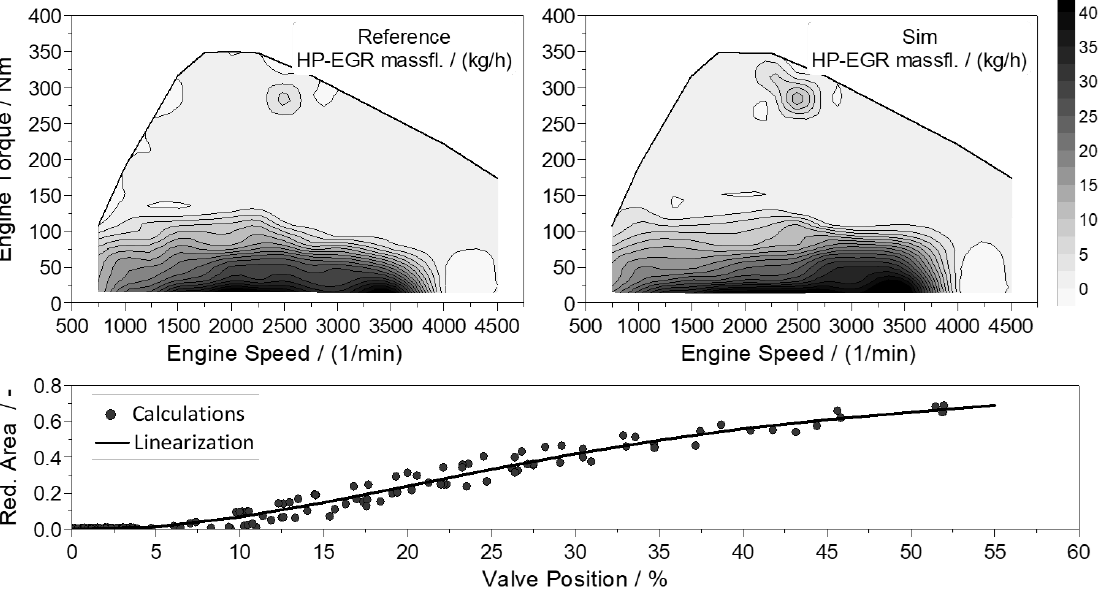
Figure 12. Comparison of the HP-EGR mass flows and deviations between calculated values for the reduced area of the HP-EGR valve and the values from linearization.